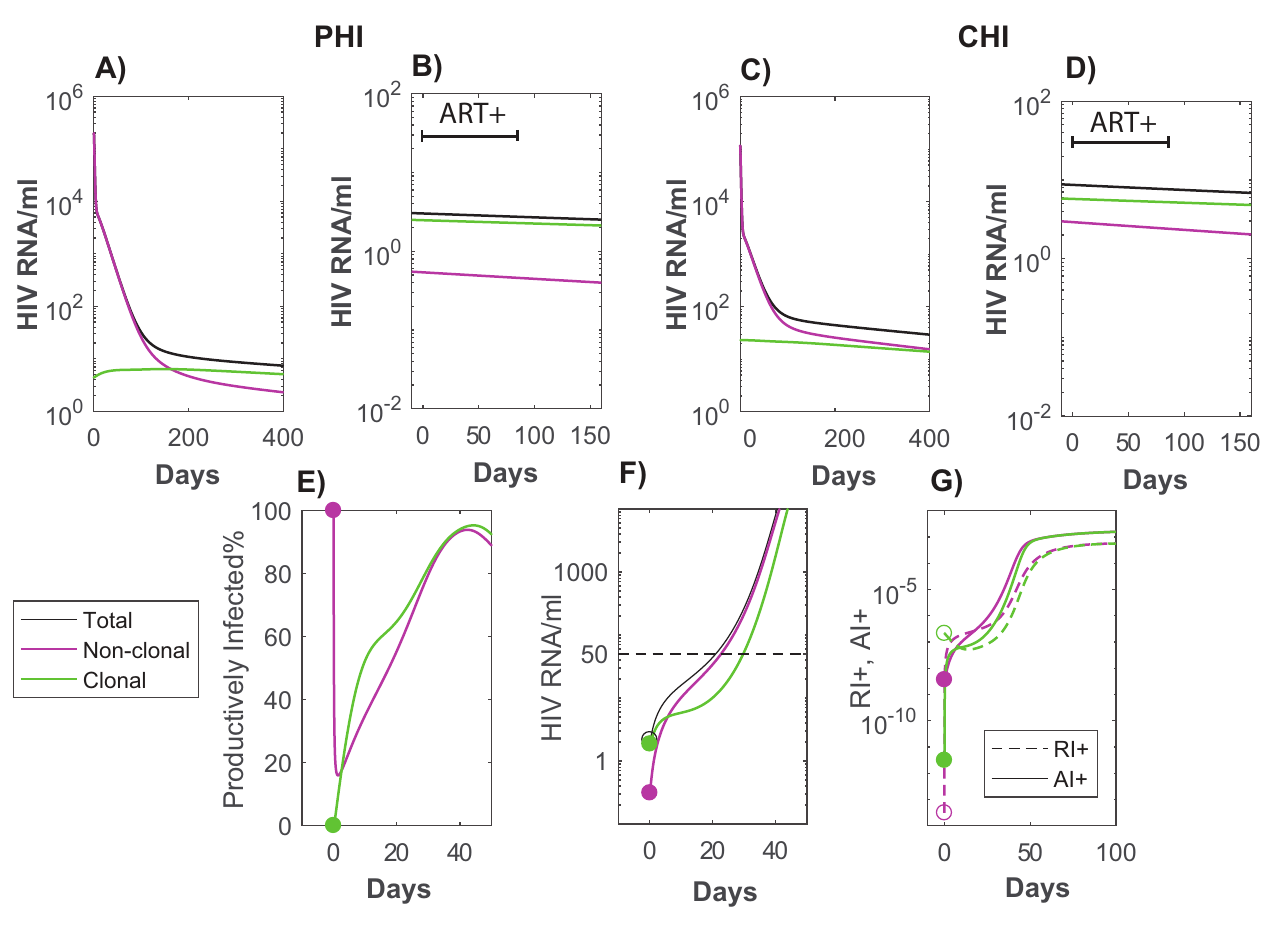
Fig 4. pVL simulations with ART (A and C), and treatment intensification after 3 years of ART (B and D). Panels A and B describe contributions to pVL for ART commenced at PHI, whileC and D describepVL commencedat CHI. pVL: total (black), arising from cells directly infected by virus (magenta), and from infected cells that were producedvia homeostaticproliferation (throughprocesseswithin the R + component)from cells with integratedHIV DNA (green). In the treatment intensification panels B) and D), time has been reset to commencement of 12 weeks ART intensification (an integrase inhibitorwith efficacy 99.9% is assumed added to a nonRALregimen which had the same overall efficacy as in Fig 3 simulations), followedby reversionto the originalART regimen at day 84. E), F), G) Reboundof pVL after stopping 6 years of ART . Here we track the origin of the resultingviremia and cellularinfectionboth in terms of whether the infected cell arose through clonal expansionor not, and whetherthe cells are in the activated dividingor resting dividinginfected phenotype.E) Percentage of productively infected cells ( A I+ ) of all virus producing cells ( A I+ + R I+ ) separatedinto clonal (green)or direct infection (magenta) origin. Prior to interruptionalmost all cells producingvirus are productively infected if they originallyarose from direct infection, whereasif the cells arose from clonalexpansionthey are mostly in the resting dividingsubset ( R I+ ). Soon after interruptionthe majority of cells are productively infected regardlessof their originalinfectiontype. F) Source of reboundingviremia by originalinfection type – thisalso tracks subsequent generationsof new infection relative to these subsets. G) Expansion of virus producing cells ( A I+ , R I+ ) relativeto their source of infection–as depicted in panel E) infectionis mostly in the productiveinfected subset ( A I+ ) regardlessof the originalsource of